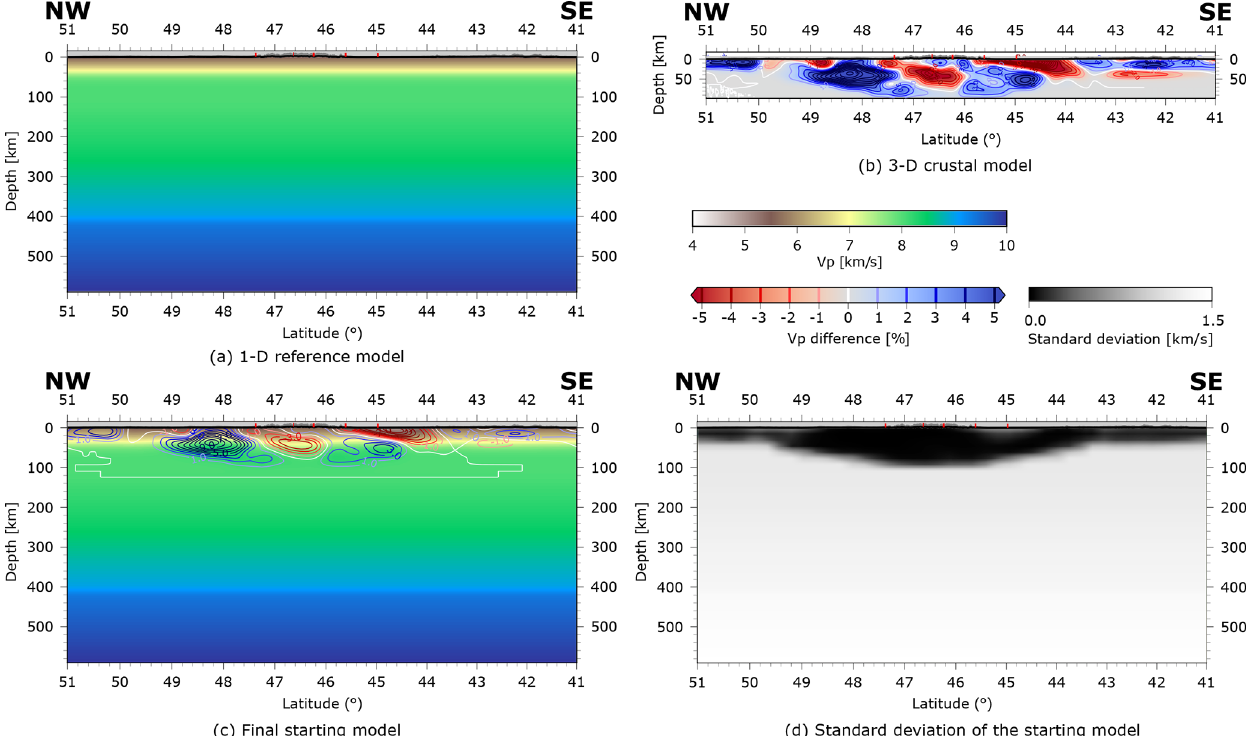
Figure A1. (a) We start of from a generic 1D reference model, typically used as a starting model for a seismic tomography, in this case our combined global standard earth model AK135 (Kennett et al., 1995), refined for the Alpine region by using the 1D reference model for the Alpine crust used by Diehl et al. (2009) (Fig. 4). (b) In the next step we superpose the perturbations of our newly calculated 3D crustal model (Sect. 2.4) onto our 1D starting model. The resulting 3D model (c) is then used as starting model for the teleseismic tomography. To control the possible alteration of this starting model during the iterative inversion process, we define an a priori variance for each velocity grid point (d) . A variance of 0 (black colour) means that the a priori model remains unchanged during the inversion (e.g. in the uppermost 60km of the crust below the central Alps), where the resolution of the crustal model is best. As the uncertainty in the crustal model velocities increases, the variance also increases (grey colours), so changes can be made during the inversion if required by the teleseismic data. For the upper mantle outside the resolvable domain of the 3D a priori model for crust and uppermost mantle, we set the a priori variance to 15% of the model reference velocity (light grey to white colours). We provide here a small example using Profile P2